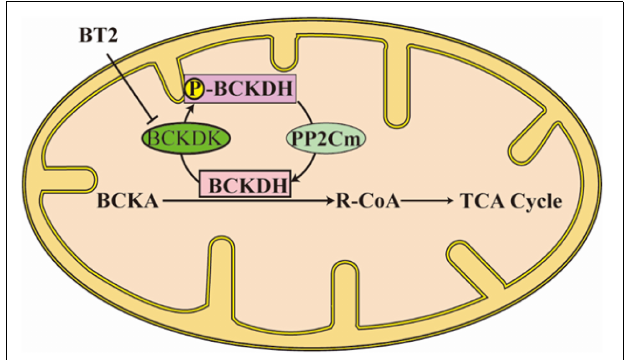
FIGURE 2 | A brief schematic of BCKA catabolism, and the enzymes that regulate this